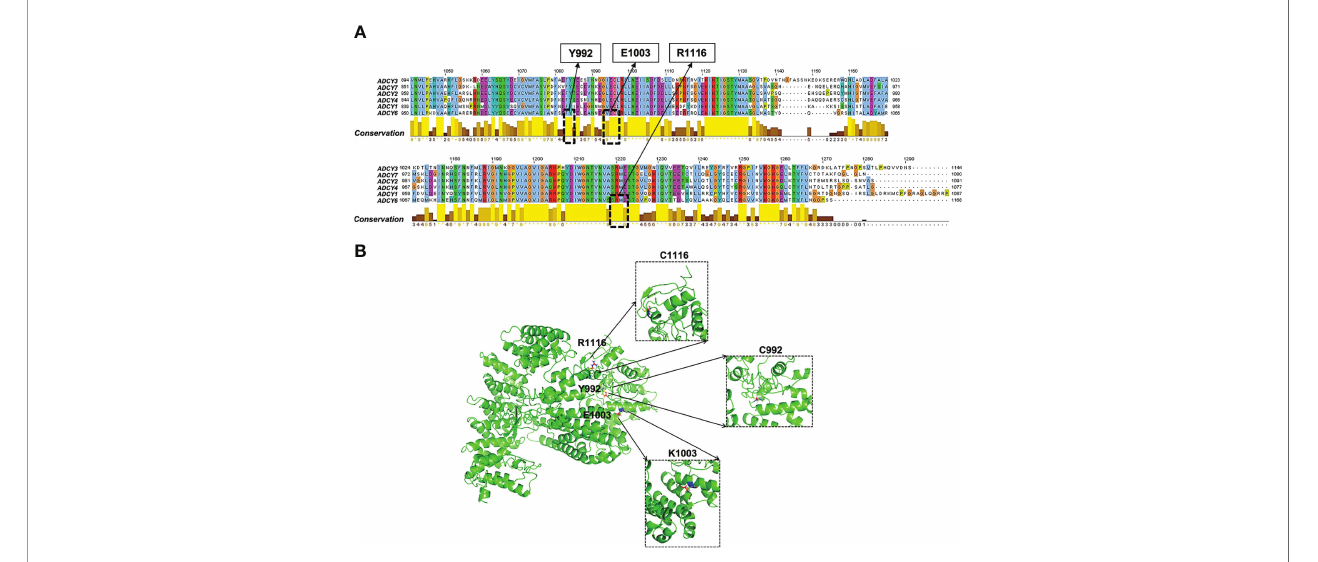
FIGURE 3 | Functional effects of pathogenic ADCY6 SNPs. (A) Multiple sequence alignment of the ADCY protein family. (B) Surface and crystallographic imaging of the ADCY6 p.E1003K and p.R1116C SNPs located in the active site of the ADCY6